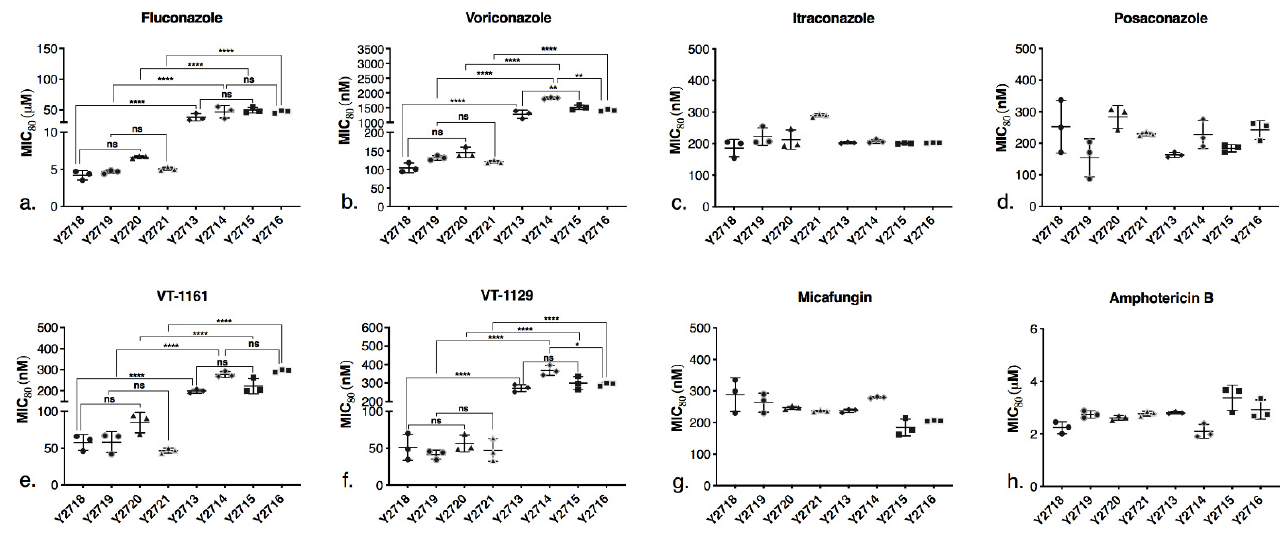
Figure 4. Comparison of MIC 80 values for recombinant strains expressing CpCYP51 or CpCYP51 Y132F to antifungals. ( a ) FLC, ( b ) VCZ, ( c ) ITC, ( d ) PCZ, ( e ) VT-1161, ( f ) VT-1129, ( g ) MCF, ( h ) AmpB. Strain description is provided in Table 1. Glucose-containing SD buffered at pH 6.8 was used. The MIC 80 values were determined in microtiter plates from the OD 600 nm values compared with no drug controls and were read after incubation for 48 h with shaking at 30 °C. The experiments were carried out in triplicates in three separate experiments for each strain and drug. The scatter plot is based on the average MIC 80 values of the three separate experiments (a total of 9 measurements per strain). The horizontal line at the centre represents the mean MIC 80 , and the error bars indicate the standard error of the mean (SEM). One-way analysis of variance (ANOVA) with post hoc Tukey’s honestly significant difference (HSD) test was performed in Graph Pad Prism 9.0 to compare the difference in susceptibility between the CpCYP51 only expressing and CPR co-expressing strains, and CpCYP51 and CpCYP51 Y132F strains. The statistical significance is shown as asterisk. * p < 0.05, ** p < 0.01, **** p < 0.0001, ns—not significant. The p values for ITC, PCZ, MCF, AmpB were ns (not shown on the plot).